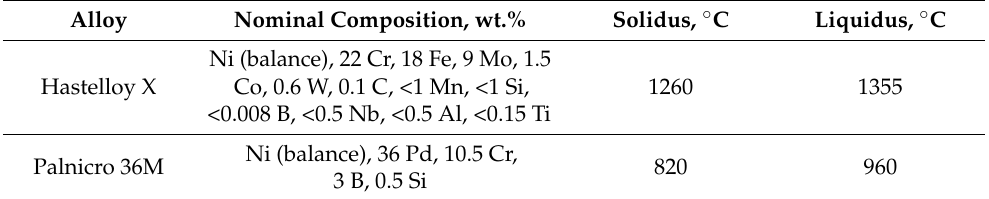
Table 1. Nominal chemical composition and melting temperature range of Hastelloy X [45] and Palnicro ‐ 36M [29] .